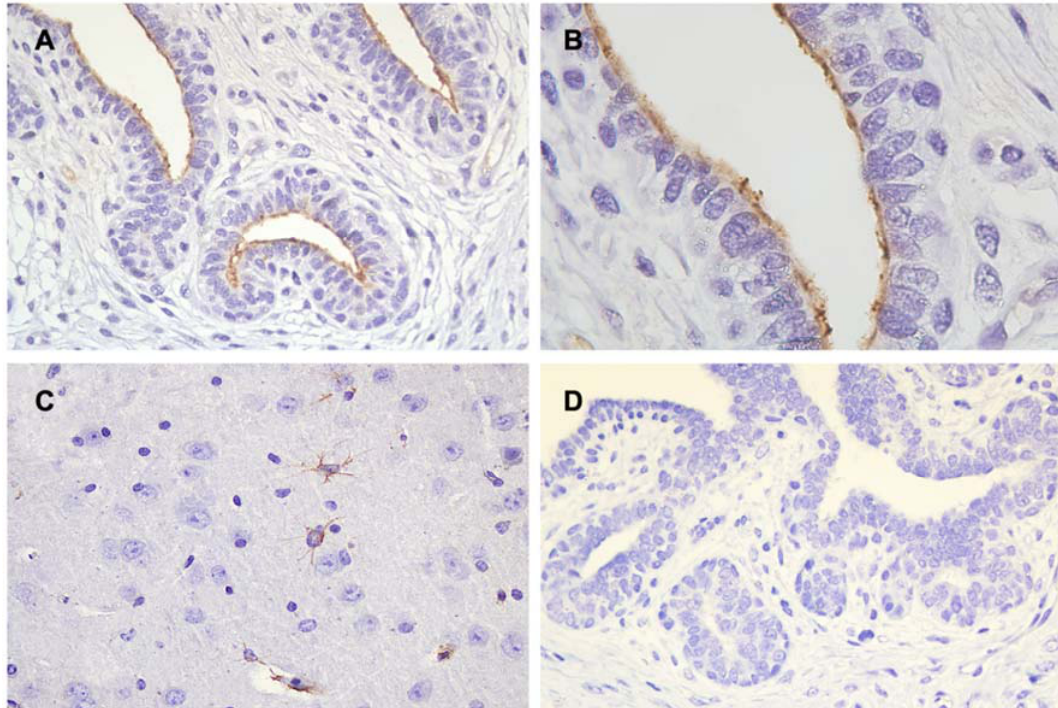
Figure 4. TRPM7 ( A ) and ( B ) immunohistochemistry in the canine mammary gland. Immuno ‐ positive staining localized in the apical membrane of ductal epithelial cells ( C ) In the positive control, positive immune ‐ reactions were observed in the perinuclear compartments and cytoplasm of the neurons in the mouse brain. ( D ) No specific staining was observed in the negative control. Cell nuclei were stained with Mayer’s hematoxylin. (A, C, D original magnification ×400; B original magnification ×1000).